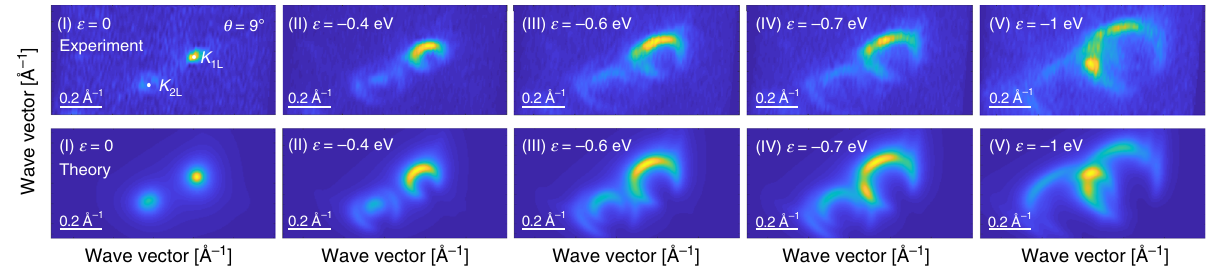
Fig. 4 Wave function symmetry in ARPES. Comparison of experimental (top row) and theoretical (bottom row) constant-energy ARPES intensity maps for twisted trilayer graphene with θ = 9 ∘ for energies indicated with grey dashed lines in Fig. 3. The intensities are normalised in